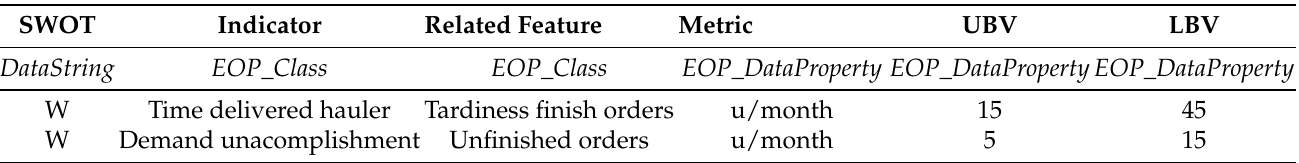
Table 8. The semantic search of key features and confidential intervals, where SWOT refers to a strength (S), weakness (W), opportunity (O), or threat (T) and EOP refers to Enterprise Ontology